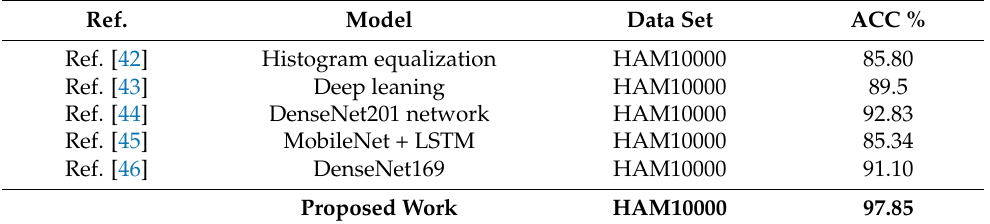
Table 6. Comparison of proposed work with some standard models and other existing models.